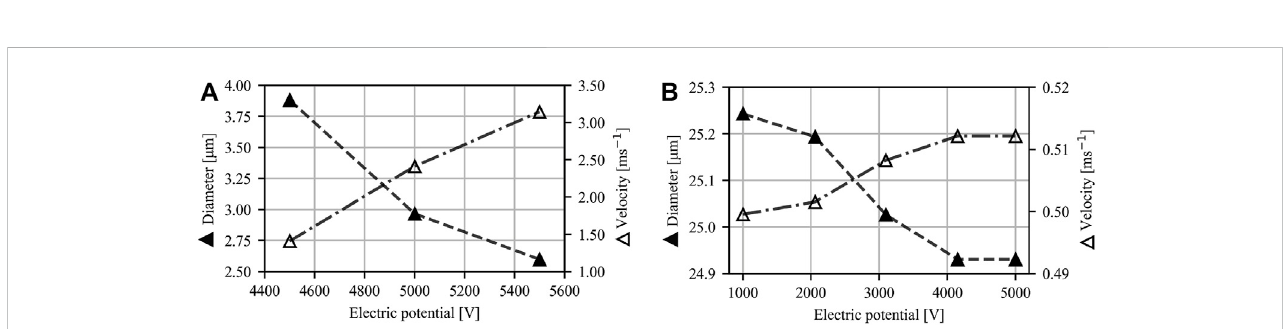
FIGURE 9 Diameter(solid triangle)andvelocitypro fi les(open triangle)forvacuumconditions. Figures show thein fl uence ofEPon jetdiameter andvelocity 30 μ m downstreamofthemeniscustojettransition (A) andnozzletip (B) .Parametersfor (A) :GFR=1.7 mg/min,SFR=1 μ l/min, L =0.36 – 0.46(highEPandlowEP). Parameters for (B) : GFR = 30 mg/min, SFR = 15 μ l/min, L = 0.75.